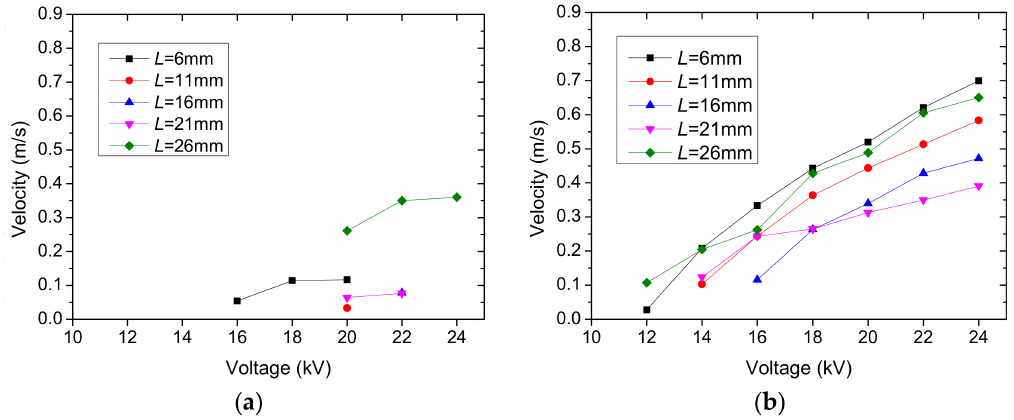
Figure 11. Variation of ionic wind velocity with the applied voltage with different needle-ring distances for four needles: ( a ) positive corona discharge; and ( b ) negative